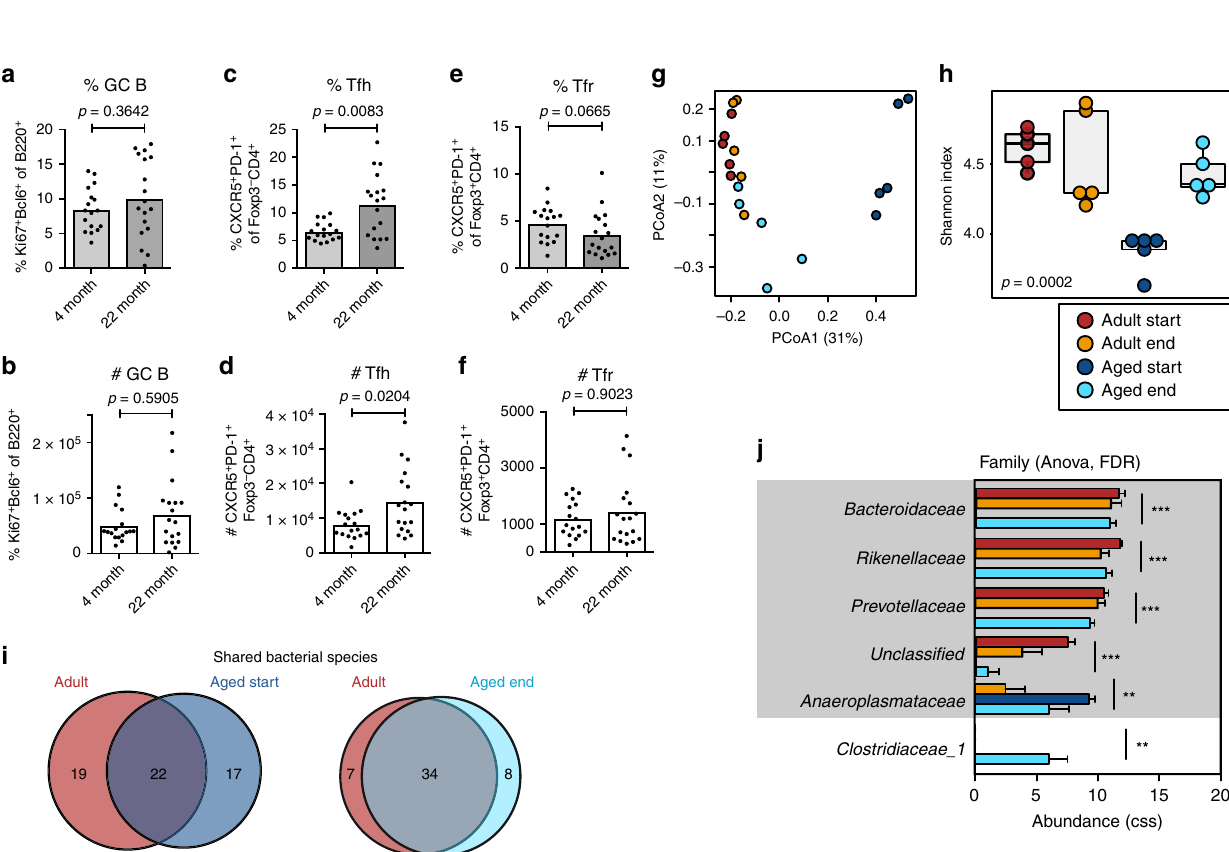
Fig. 3 Co-housing boosts the gut germinal centre response of aged BALB/c mice. Adult and aged female BALB/c mice were co-housed for 30 – 40 days, then Peyer ’ s patch (PP) germinal centre (GC) cell populations were analysed by fl ow cytometry. The percentage and number of B220 + Ki67 + Bcl6 + GC B cells ( a , b ), CD4 + Foxp3 - CXCR5 + PD-1 + Tfh cells ( c , d ) and CD4 + Foxp3 + CXCR5 + PD-1 + Tfr cells ( e , f ) in Peyer ’ s patches. g – j 16S rRNA sequencing data were generated from faecal pellets collected from 5 adult and 5 aged BALB/c mice at the start and end of co-housing ( n = 5 mice per group). Samples were clustered by Bray-Curtis PCoA ( g ) and bacterial diversities were measured by the Shannon index ( h ). The overall p -value was based on ANOVA tests. i Venn diagrams showing the numbers of shared and unique bacterial species detected in both age groups of mice before co-housing and after co-housing. j Depiction of bacterial families whose abundance was signi fi cantly different between co-housed BALB/c mice as determined by ANOVA analysis after cumulative-sum scaling (CSS). *FDR ≤ 0.05, **FDR ≤ 0.01, ***FDR ≤ 0.001. Families previously found to be signi fi cantly decreased in aged versus adult BALB/c mice before co-housing are marked in grey. In a – f bar plots show the combined results of 2 independent experiments with a total of n = 17 – 18 mice per group. Bar height corresponds to the mean, and each circle represents one biological replicate. P -values were determined using the Mann – Whitney test in GraphPad Prism6. Source data are provided as a Source Data fi le